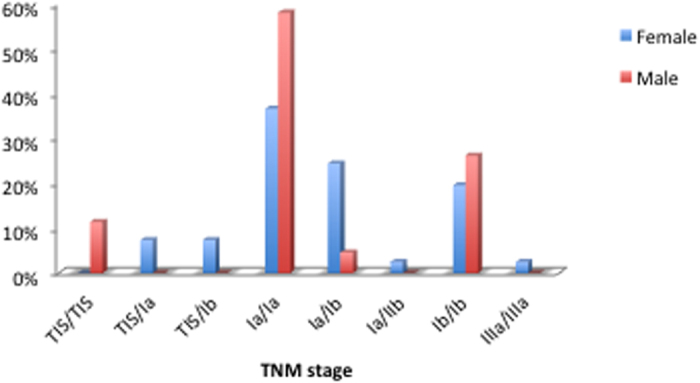
The TNM stages profile of these MPLC patients.